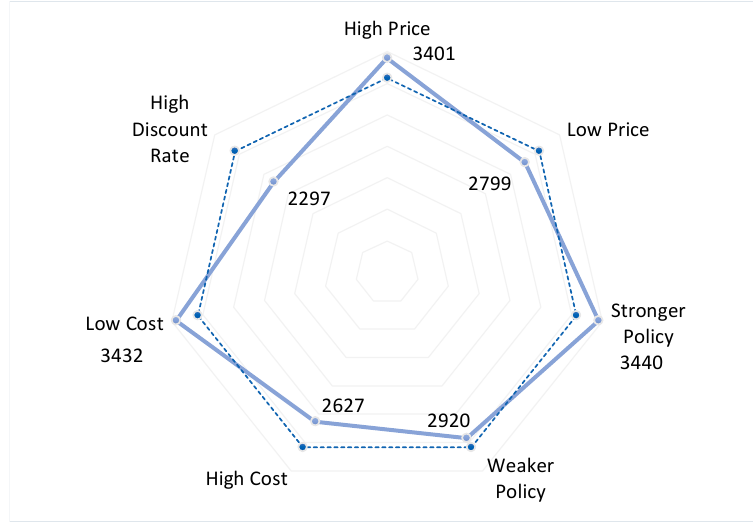
Figure 10. Overview of the installed solar PV capacity in single-family houses by 2050 (MW), according to different policy schemes, electricity price levels, specific investment cost, and discount rates, compared to the “Reference” scenario (dotted line).